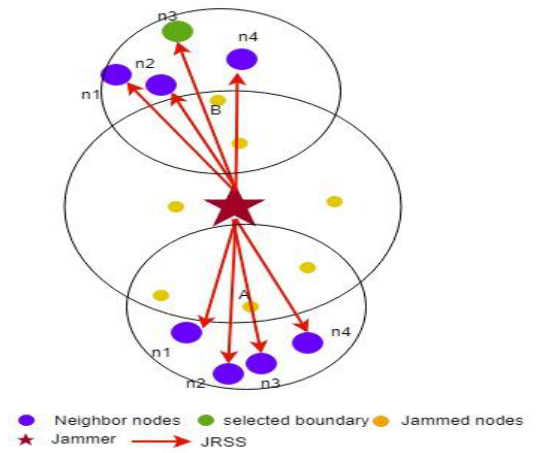
Figure 2. Selecting reference node to compute BNST value.